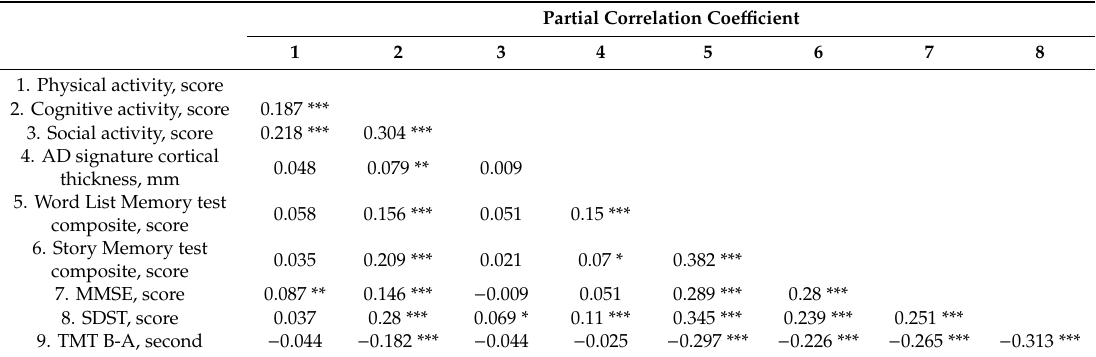
Table 2. Partial correlations among activities, cortical thickness, and cognitive